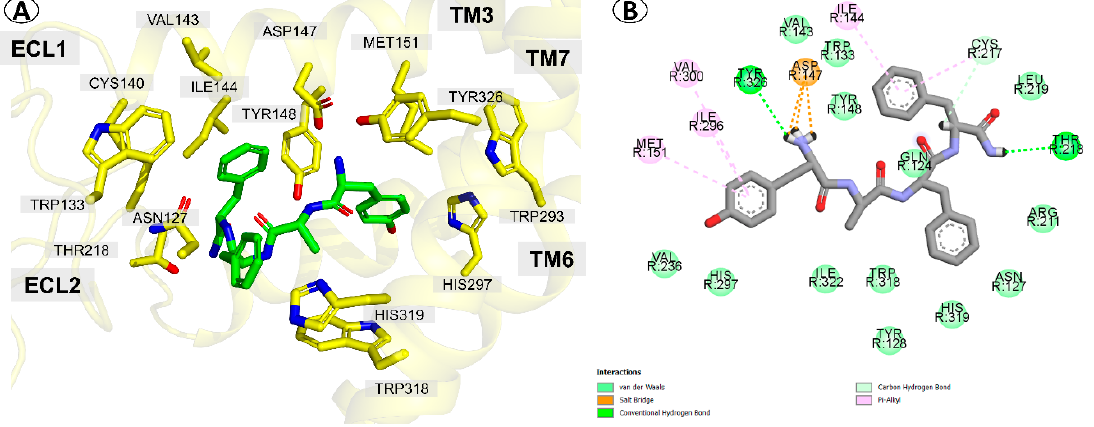
Figure 2. µOR binding mode of the parent compound (TAPP, 1 ) as predicted by docking. ( A ) The peptide (green sticks) in the binding site of the receptor (yellow). Side chains of only several residues are shown. ( B ) The interactions scheme.